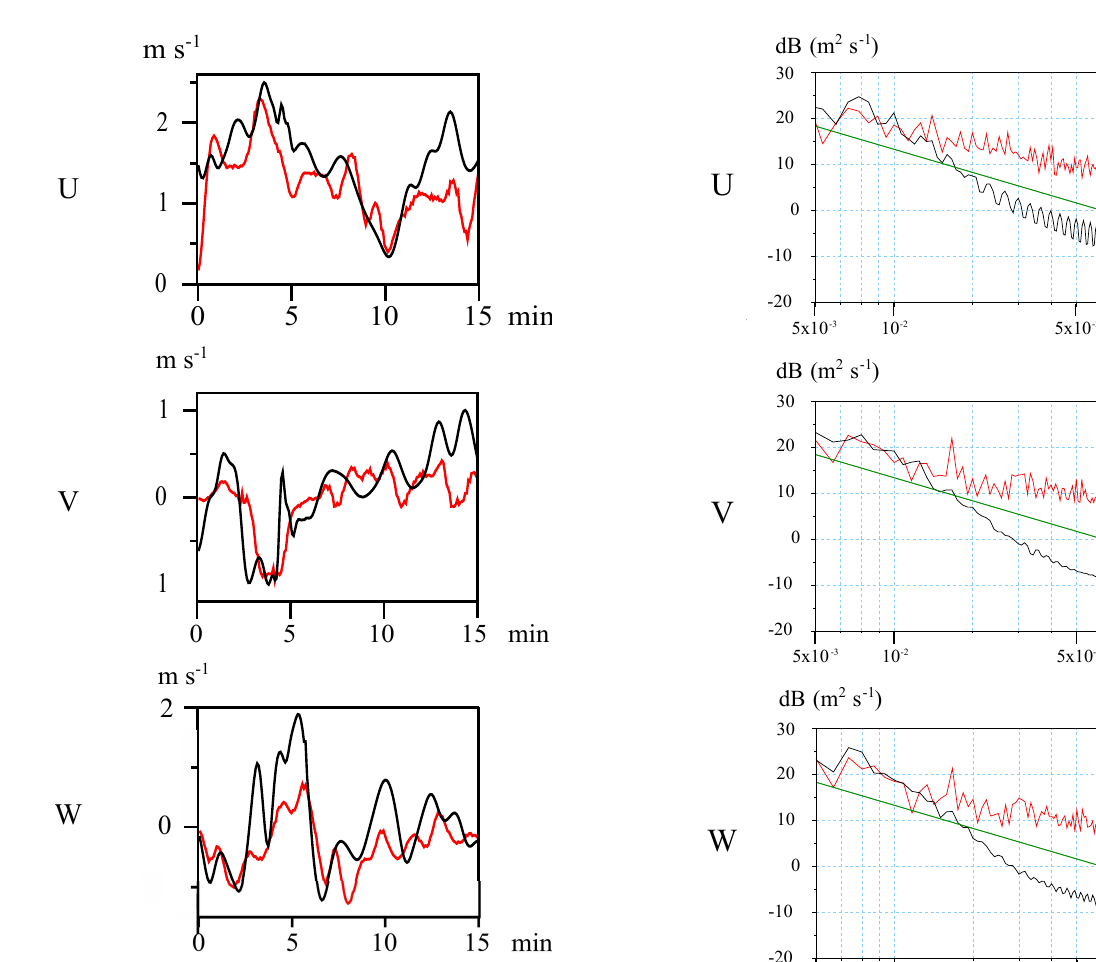
Figure 7. Components of the fine Meso-NH wind in black and com- ponents of the particle wind in red, for one cell on the second level of the fine grid.